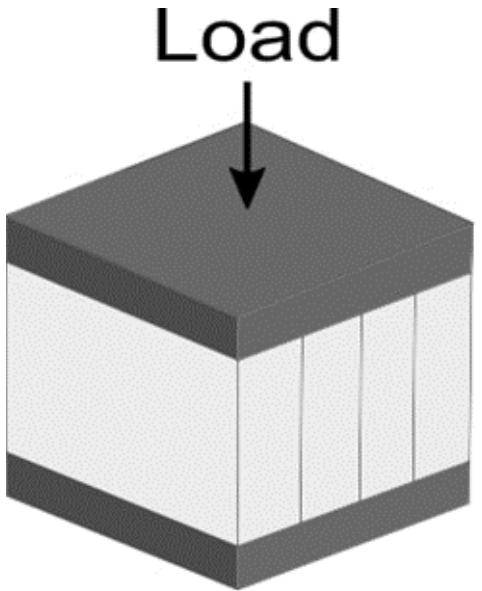
Figure 4. Loading direction force for 3D-printed samples.